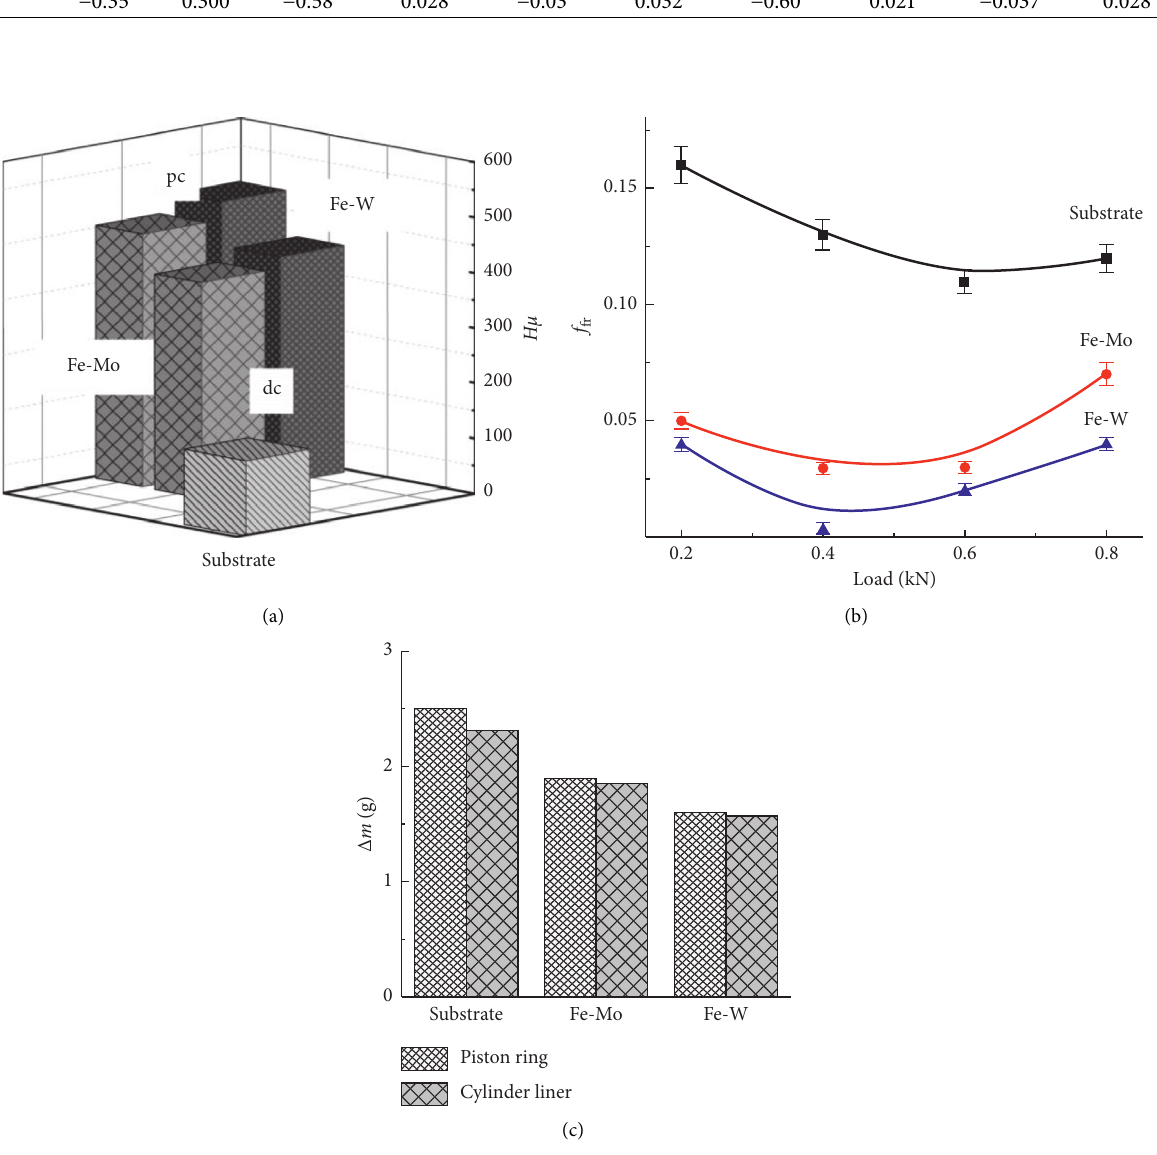
Figure 2: Mechanical characteristics of Fe-Mo(W) based composites: (a) microhardness; (b) friction coefficient; (c) wear